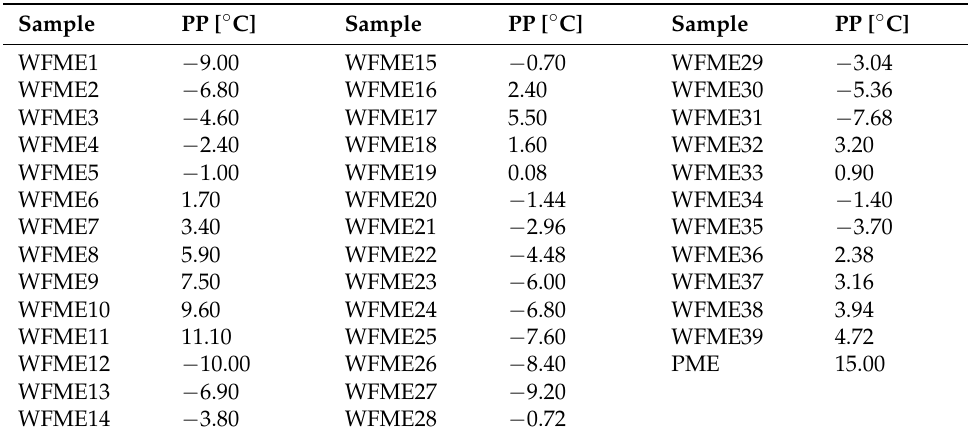
Table 7. Pour point (PP) values for all biodiesel